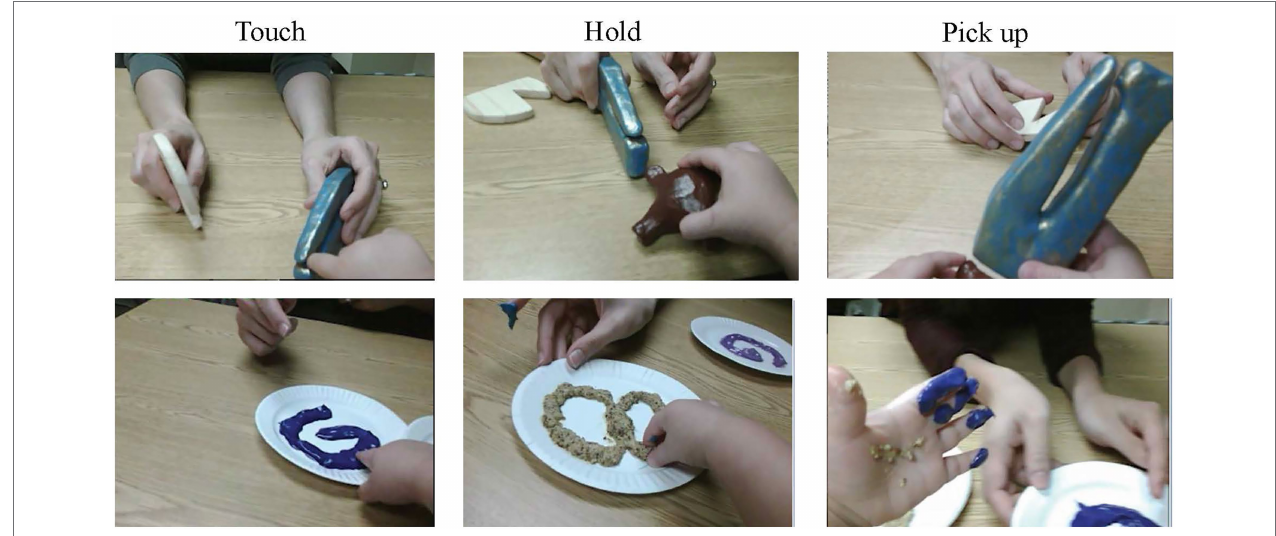
FIGURE 3 | Examples of children’s touch, hold, and pick up behaviors (from left to right) coded for solid (top) and nonsolid (bottom) exemplars during